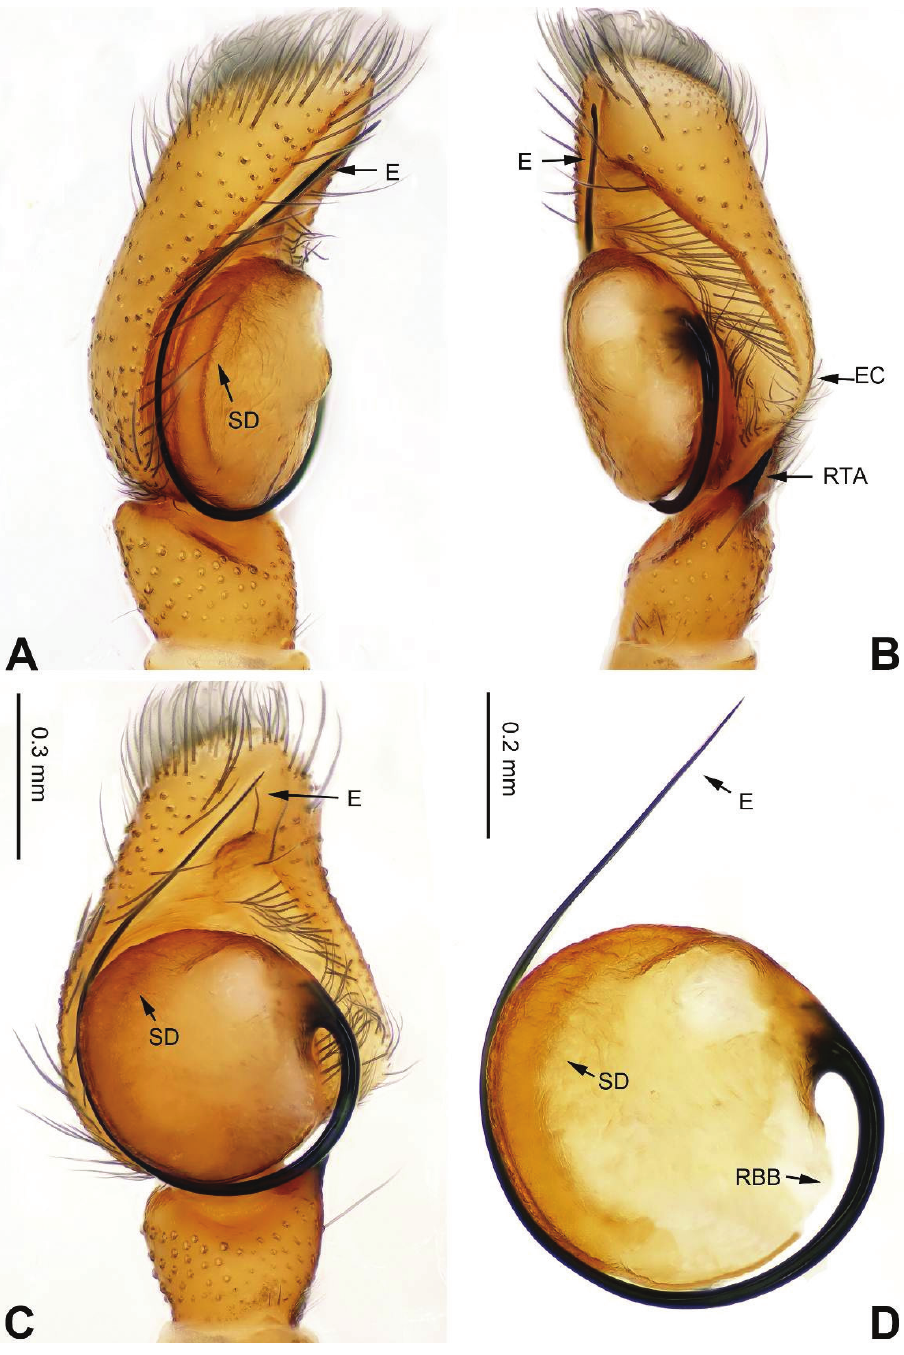
Figure 38. Palp of Ptocasius paraweyersi sp. n., male holotype. A prolateral B retrolateral C ventral D bulb, ventral. Scale bar equal for A–C